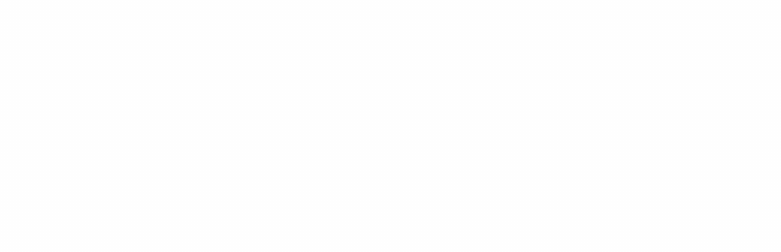
FIGURE 5 Replacement of the lower part ofmantle lithosphere by a less dense asthenosphere which produces the crustal uplift at the Earth’s